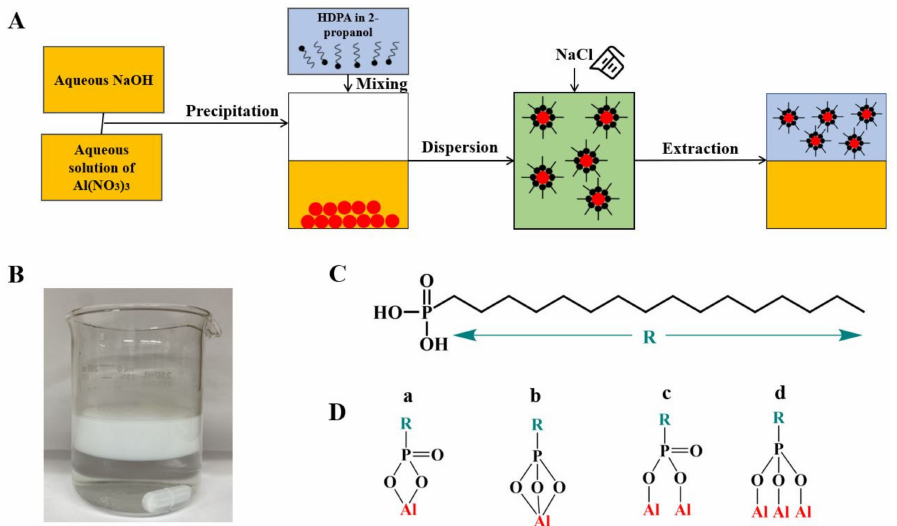
Figure 6. ( A ) Synthesis and salting out dispersive extraction of Al(OH) 3 particles, ( B ) extraction of HDPA dispersed Al(OH) 3 particles to 2-propanol, ( C ) HDPA structure, ( D ) HDPA adsorption mechanisms, involving ( a , b ) chelating or ( c , d ) bridging.